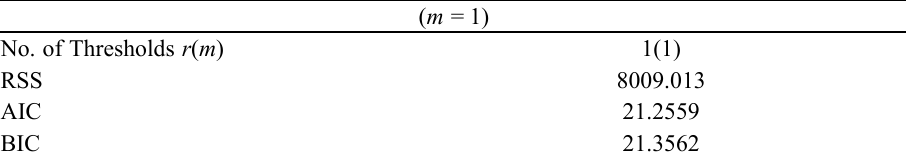
Table 3. Determination of the number of regimes for large-sized